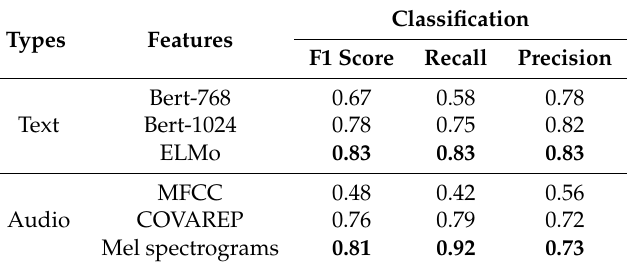
Table 5. Performance comparison using different features.